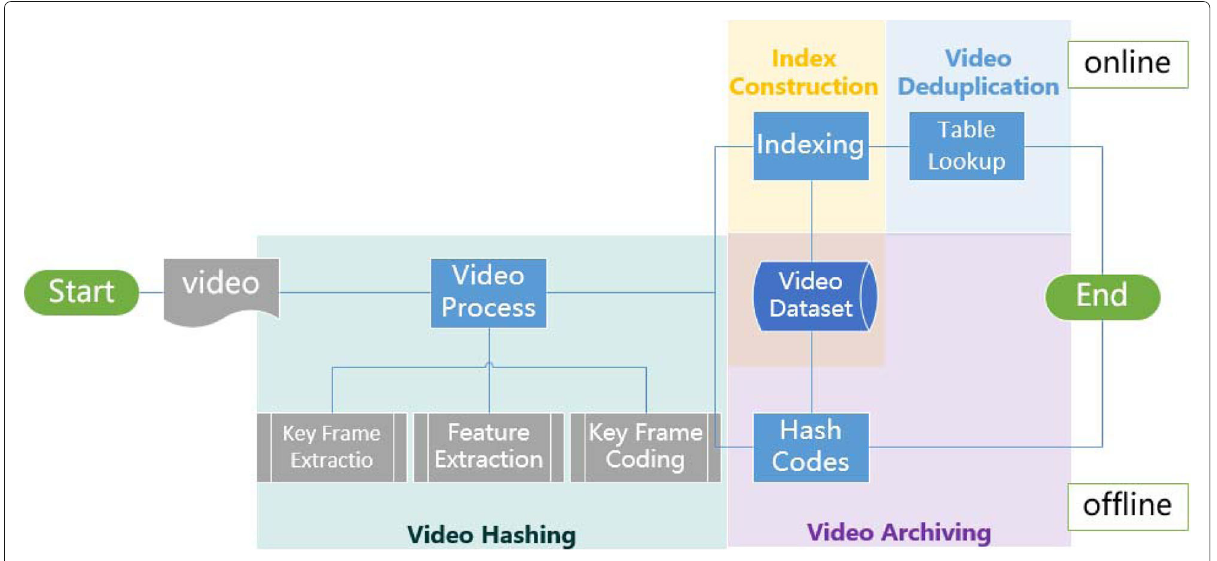
Fig. 1 Proposed hash-based framework for fast video deduplication